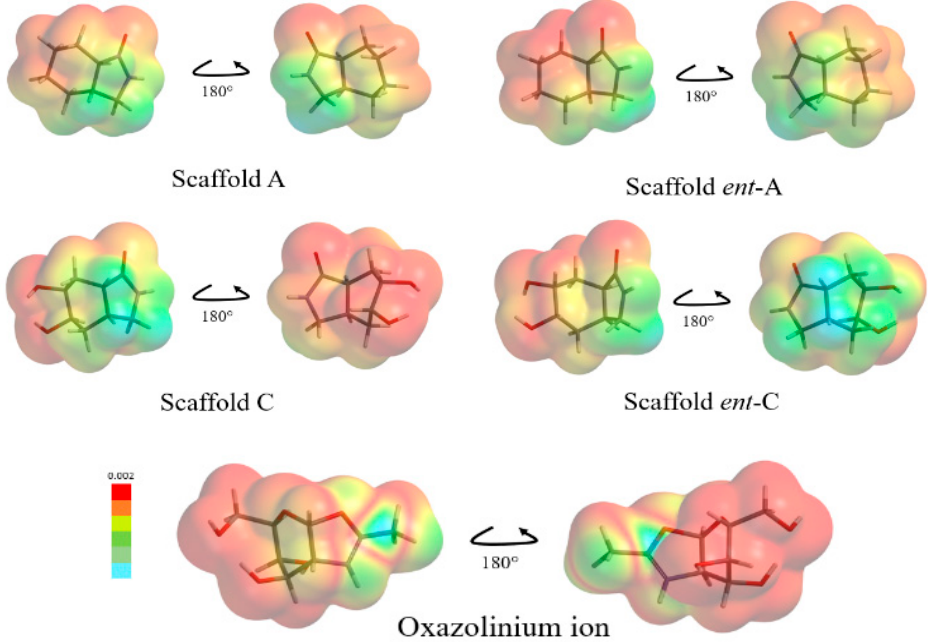
Figure 8. Lowest molecular orbital (LUMO) map of scaffo ld proposals in comparison with the oxazolinium ion fragment. Colors go from red (minimum value) to blue (maximum value) according to the absolute value of the LUMO on the electron density surface.